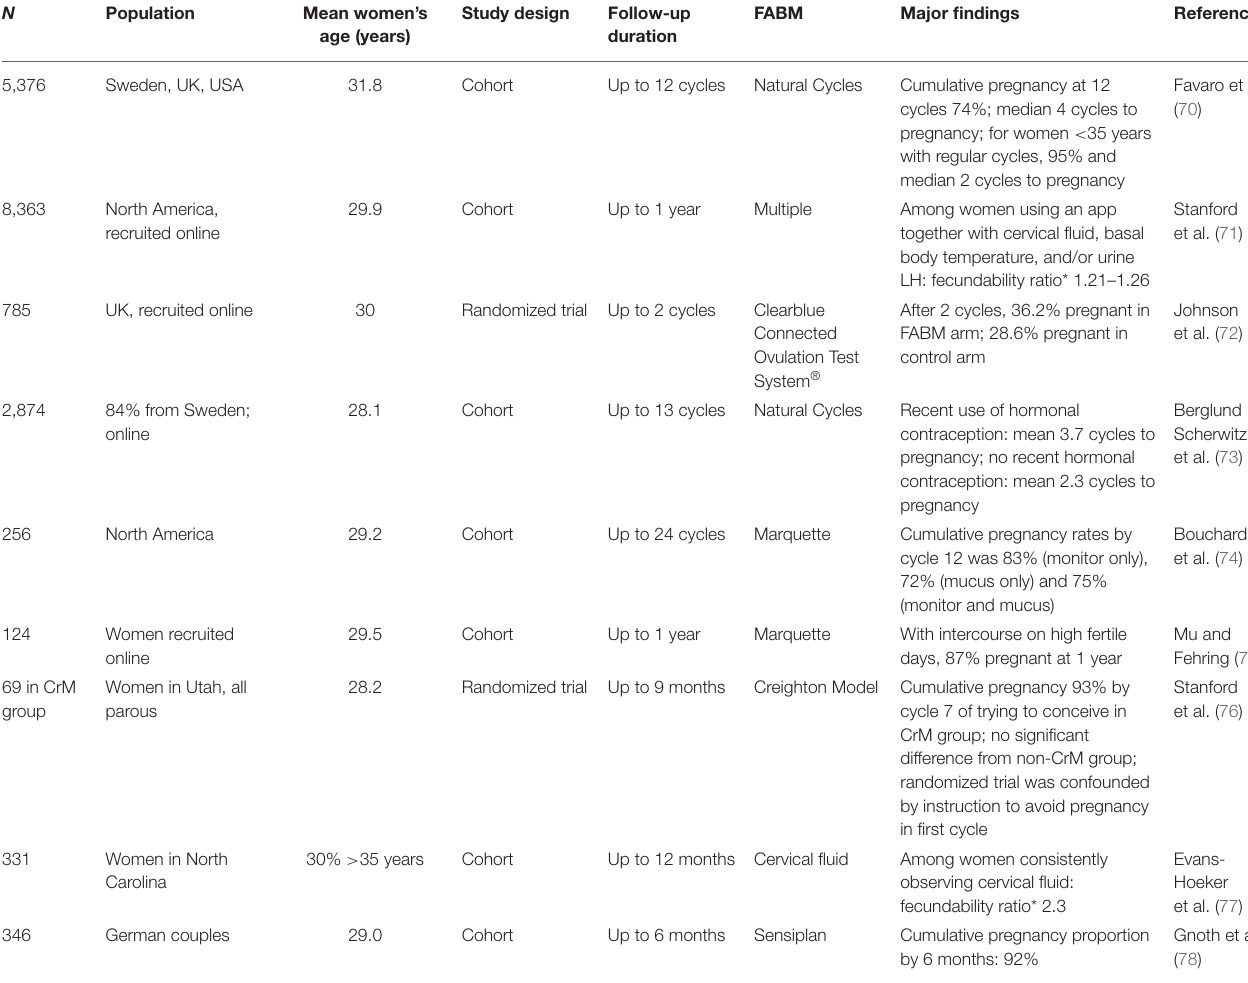
TABLE 4 | Fertility awareness-based methods and time to pregnancy in women or couples with no known subfertility trying to conceive.